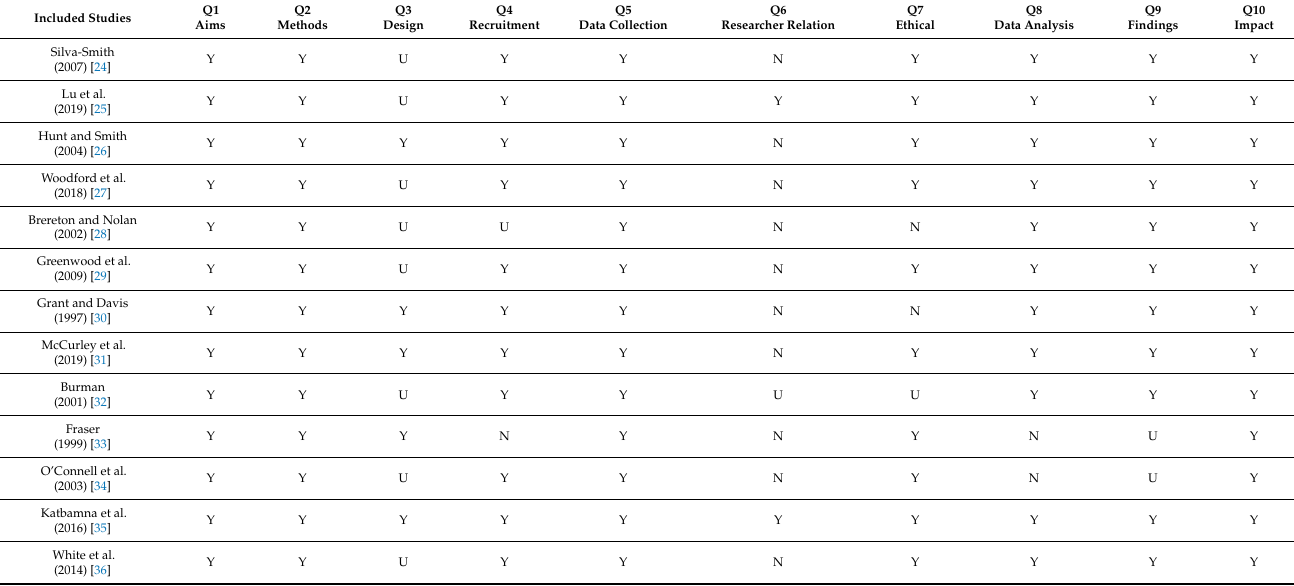
Table 3. Study quality